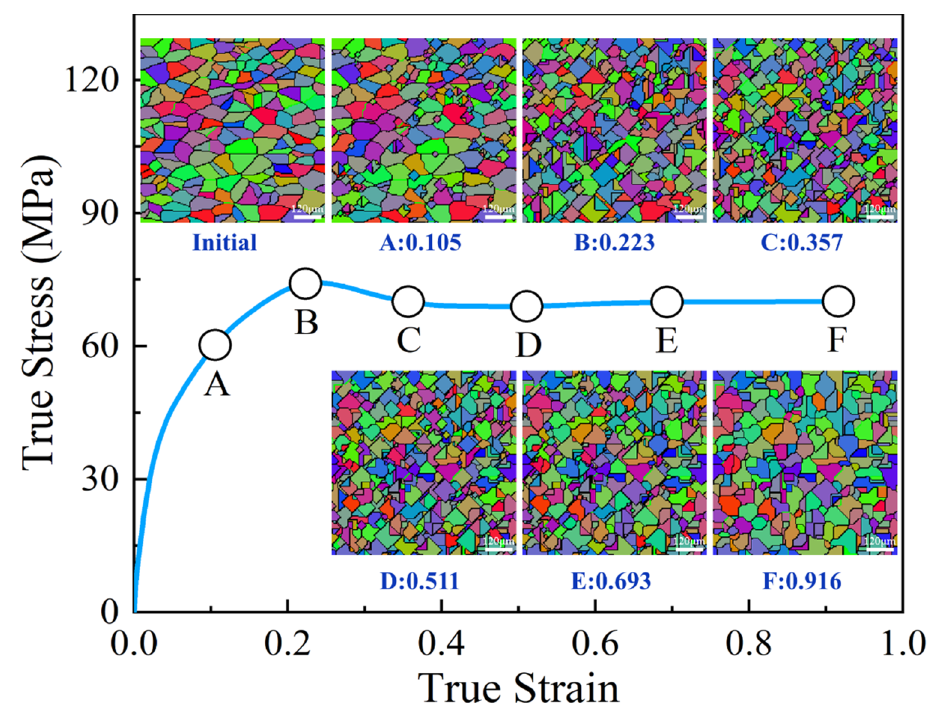
Figure 21. Evolution process of grain morphology under the temperature of 1303 K and strain rate of 0.1 s − 1 .